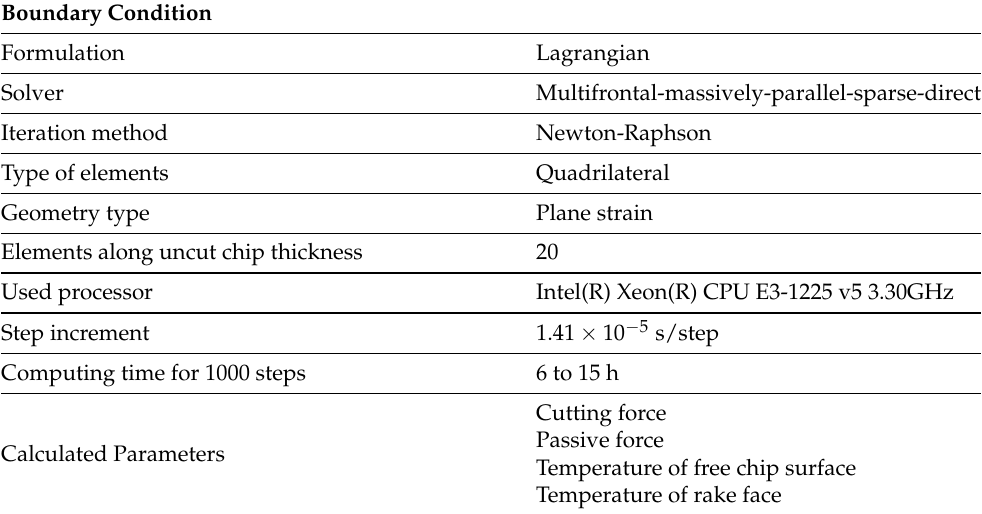
Table 6. Boundary conditions of the finite element